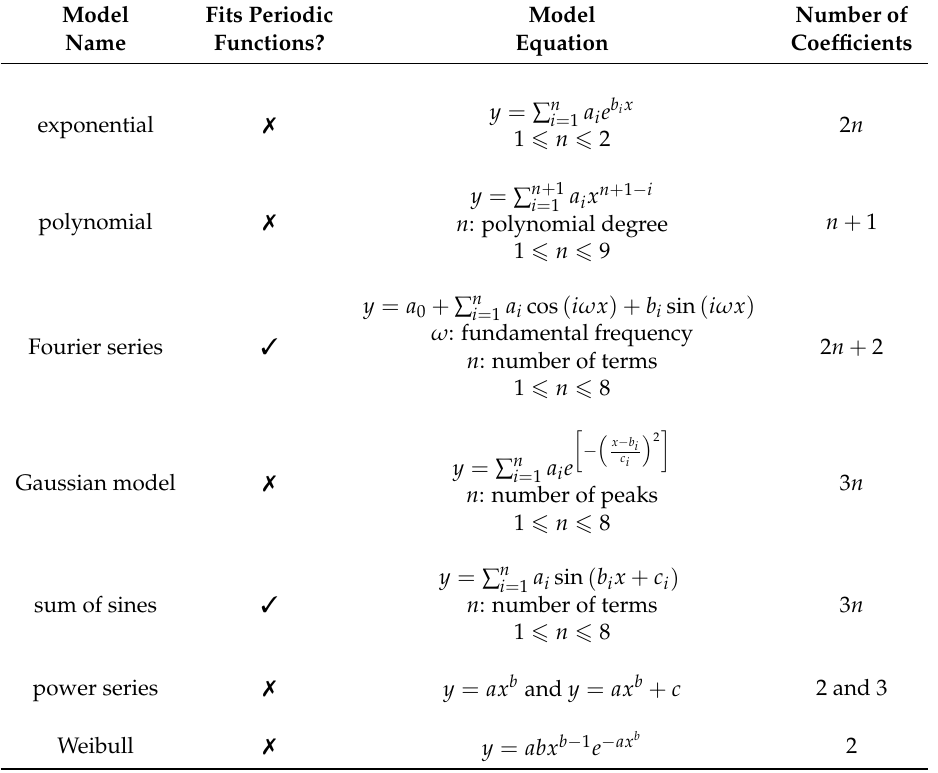
Table 1. Fitting models exploited to approximate the pulse